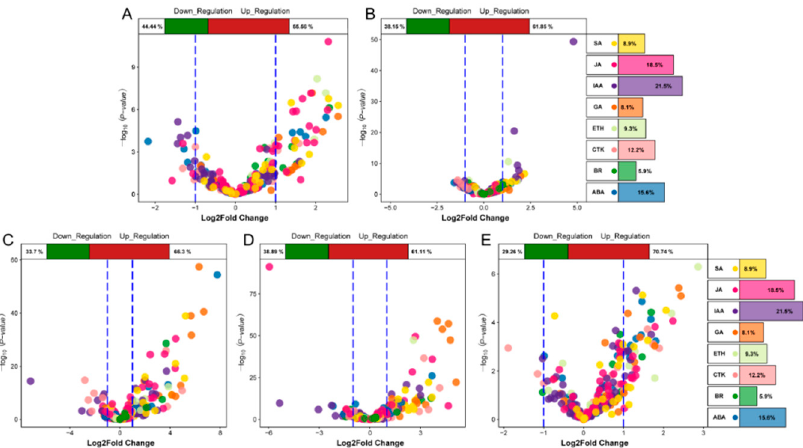
Figure 6. Volcanic plot of hormone-associated genes. The top of the volcano plot shows the proportion of up-regulated and down-regulated genes. The right side of the volcano plot shows the ratio of the number of hormone-associated genes. Di ff erent colors represent specific hormone types. ( A , B ) represent volcano plots of hormone-associated genes during jointing stages. ( C , D , E ) represent volcano plots of hormone-associated genes during panicle